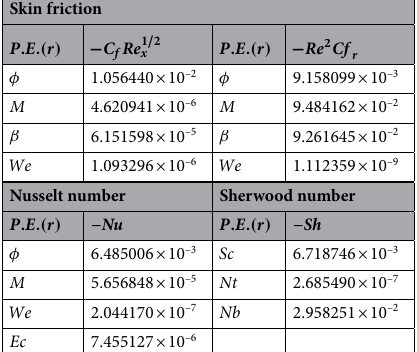
Table 7. Numerical values of P.E. for Skin friction and Nusselt number NuRe −